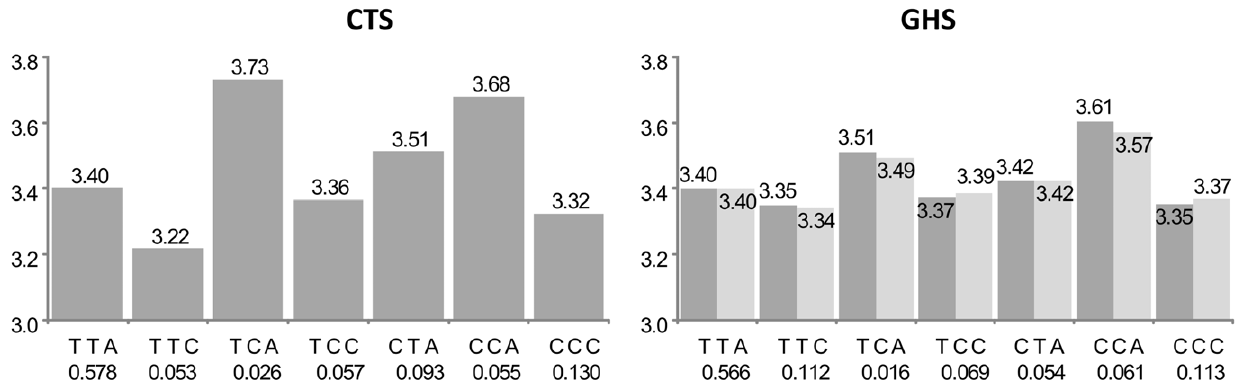
Figure 5. Association between ILMN_1689088 ( COLEC12 ) expression and the main haplotypes derived from rs9966524, rs9960856, and rs2846666. See the first paragraph of legend in Figure 2 for explanations. In CTS, the rs9966524 and rs2846666 were substituted by their corresponding proxies, rs3932728 (r 2 =0.82) and rs2846667 (r 2 =0.87). The original haplotypic association (dark grey bars) was due to two haplotypes associated with increased COLEC12 expression, the TCA ( b = + 0.331 p=3.07 10 2 10 and b = + 0.111, p=5.83 10 2 4 , in CTS and GHS, respectively) and the CCA ( b = + 0.278 p=5.96 10 2 18 and b = + 0.204, p=4.19 10 2 60 , in CTS and GHS, resp.). In GHS, the best imputed cis eSNP was rs11081136 whose minor allele was associated with increased COLEC12 expression ( b = + 0.091, p=1.02 10 2 26 ). After adjustment for rs11081136 (light grey bars), the TCA ( b = + 0.092, p=2.52 10 2 3 ) and CCA ( b = + 0.171, p=1.39 10 2 40 ) haplotypes were still associated with COLEC12 expression. The rs11081136 effect also remained significant ( b = + 0.061, p=1.12 10 2 13